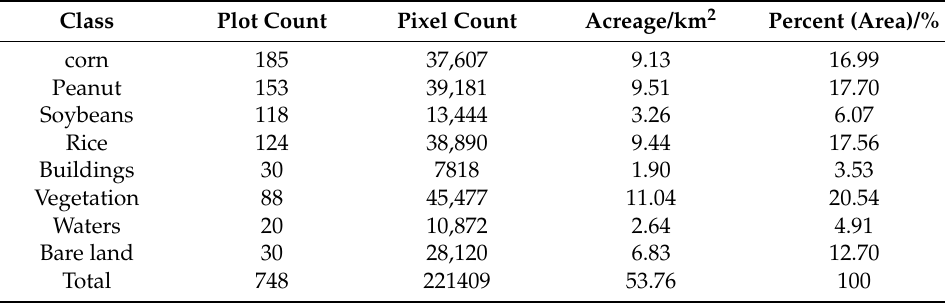
Table 3. The distribution of per class of the ground truth.